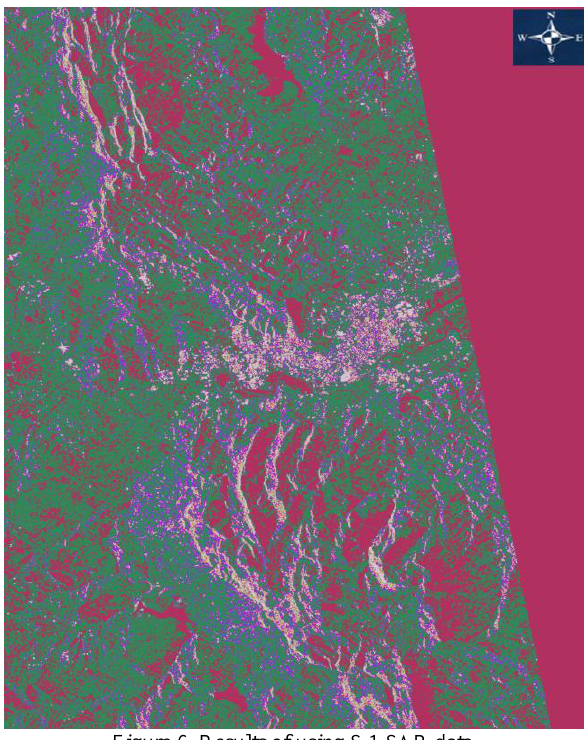
Figure 6. Results of using S 1 SAR data.